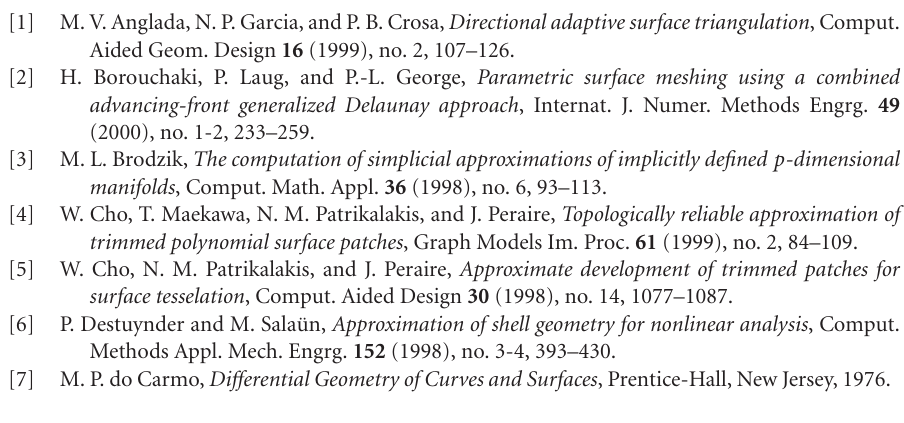
Table 7.1. Approximation of